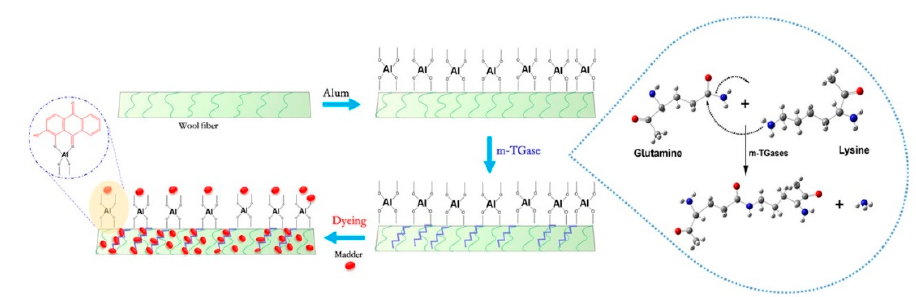
Figure 6. The schematic illustration for the proposed mechanism of treated wool with alum and m- TGase.